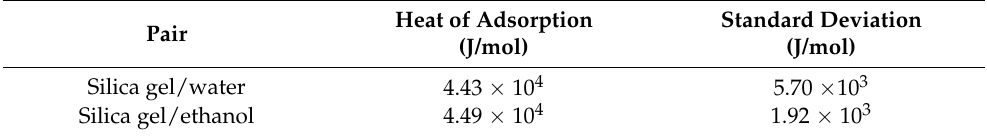
Table 2. The experimentally determined heat of